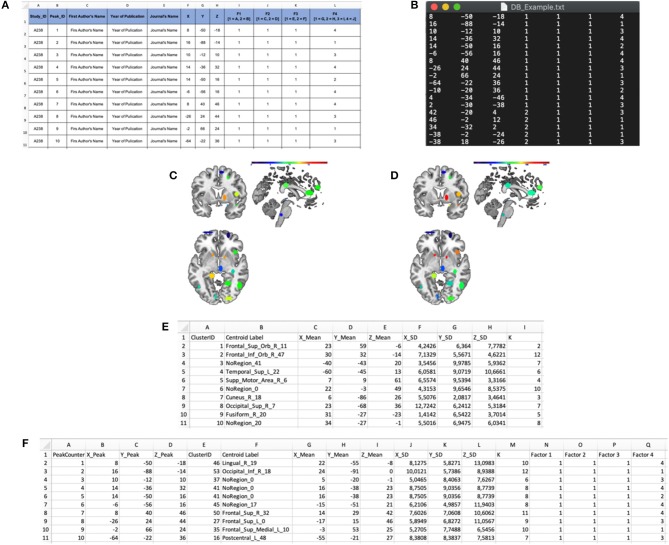
Input and output files of the “Cluster Analysis” module. (A) Example of a dataset in a spreadsheet file. (B) Example of an input .txt file. The first three columns represent the x, y, and z coordinates in stereotaxic space, whereas the last four columns represent the categorical factors (F1, F2, F3, and F4). In particular, the number in these columns represents the level of each factor for every peak. (C) “Cardinality” map representing the number of peaks included in each cluster. (D) “Density” map representing the ratio of the cardinality and the spatial extent of the cluster. (E) “Cluster Mapping” spreadsheet file in which the anatomical and spatial information about the clusters is stored. (F) “Peaks Clustering” spreadsheet file in which each peak is associated with its cluster.